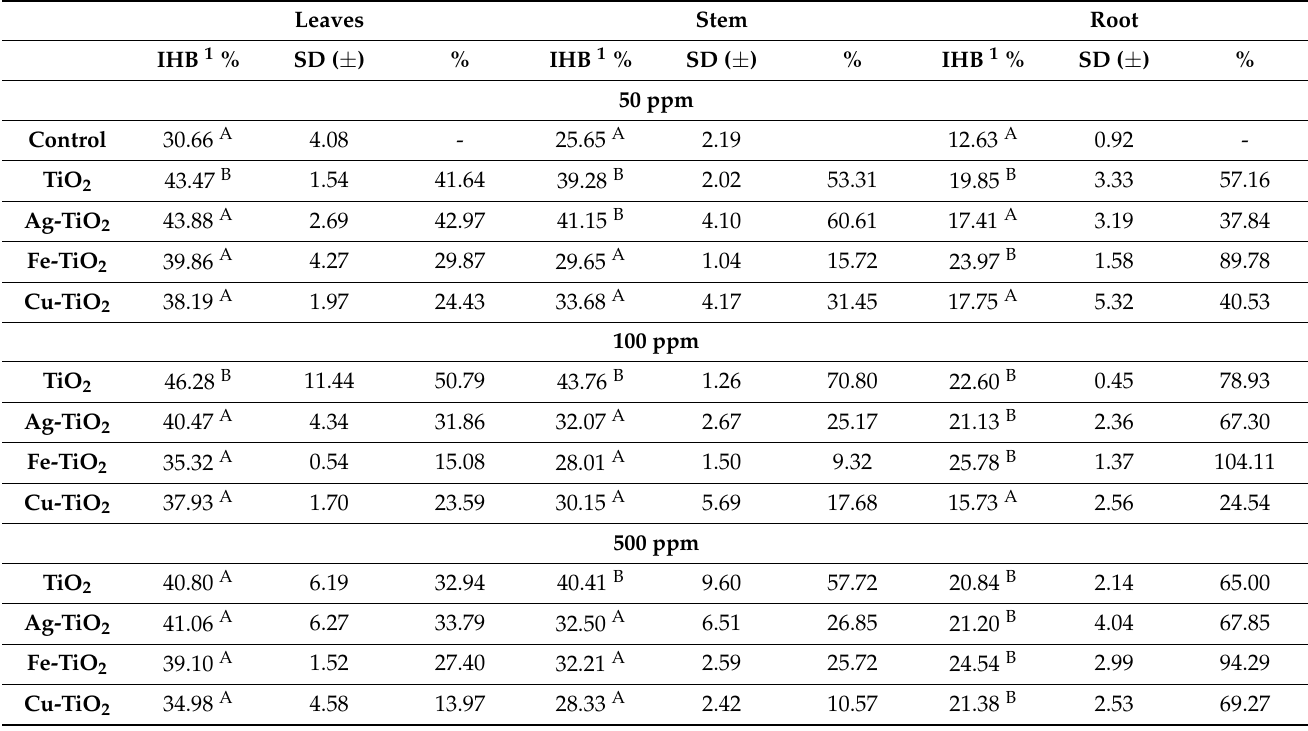
Table 4. DPPH inhibition (IHB) % in plants treated with SG